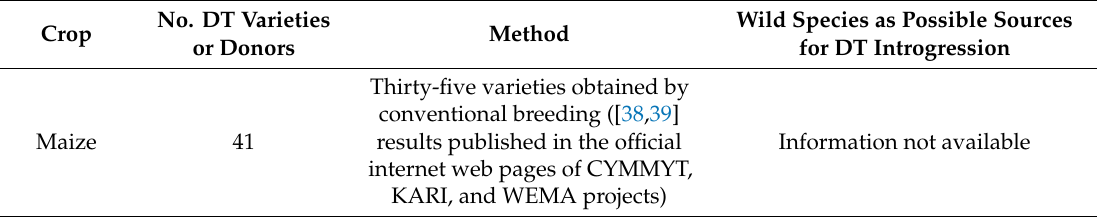
Table 1. Progress in the improvement of drought tolerance (DT) in major crops, number of drought-tolerant varieties or donors selected using conventional breeding, and the use of crop wild relatives as sources of drought-tolerant